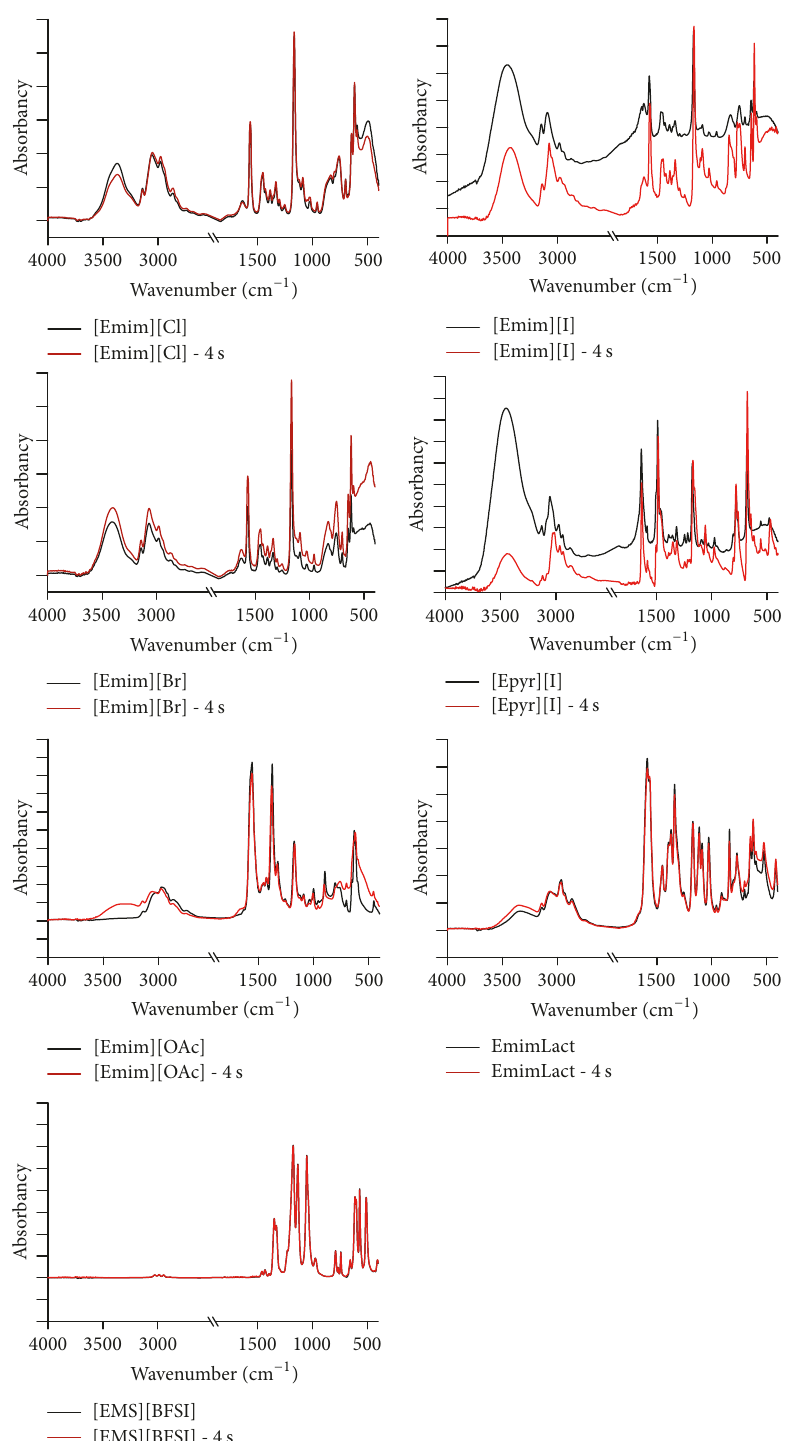
Figure 4: FTIR spectra of tested ionic liquids; black line: new ionic liquid, red: ionic liquids recovered after 4 s.